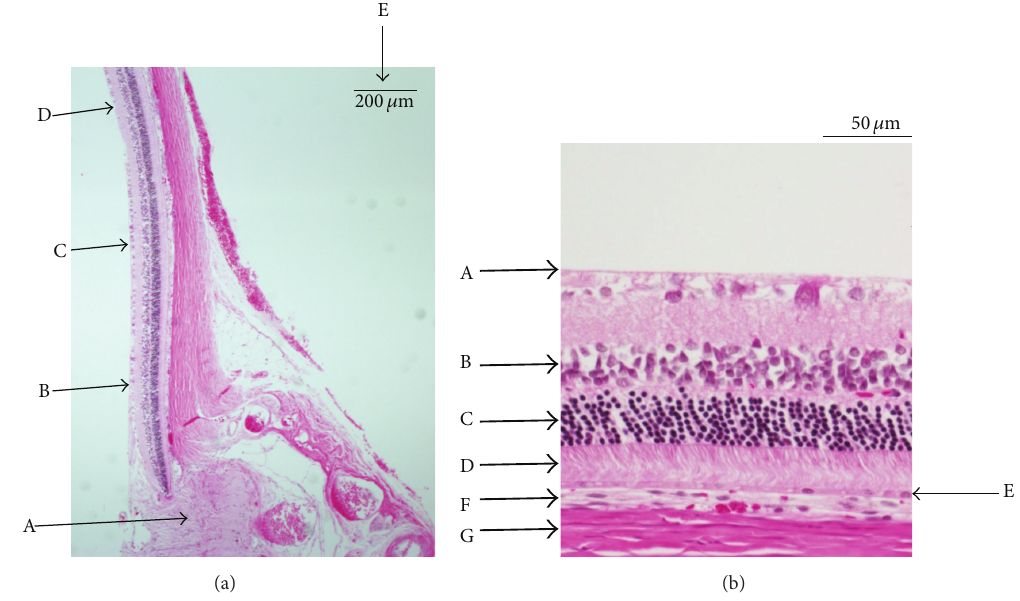
Figure 7: (a) The retina in a SDT rat (hematoxylin and eosin stain). A: optic nerve disc. B–D: the points 500, 1,000, and 1,500 𝜇 m from the optic nerve disc, respectively. E: index bar = 200 𝜇 m. (b) The retina and choroid 400 to 600 𝜇 m from the optic nerve disc. A: ILM. B: INL. C: ONL. D: PL. E: RPE. F: choroid. G: